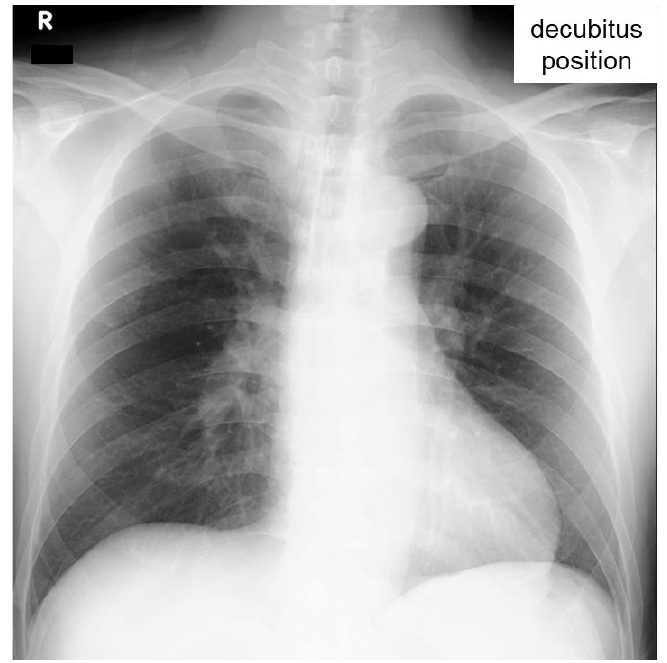
Figure 1. Chest radiograph. Patient’s chest radiography performed on admission and demonstrating slightly increased permeability in the middle lung fields bilaterally.